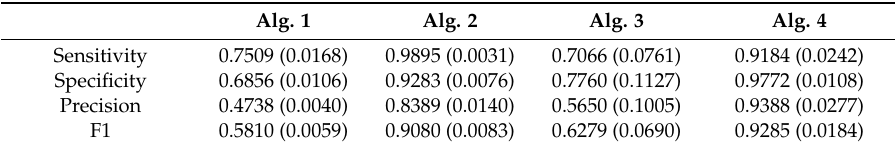
Table 6. A 10-fold cross-validation of the presented algorithms using the MobiAct dataset. The table shows the average values and the standard deviations in parentheses.